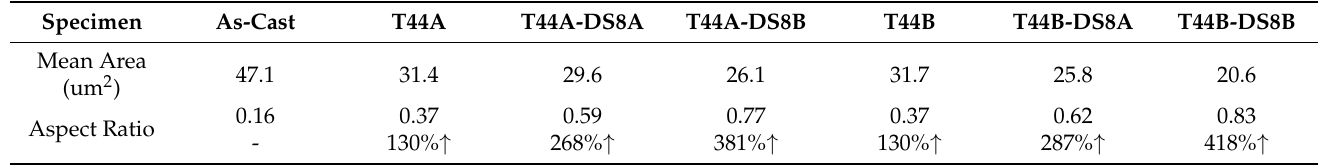
Table 3. Silicon particle characteristic of the alloy after the solution